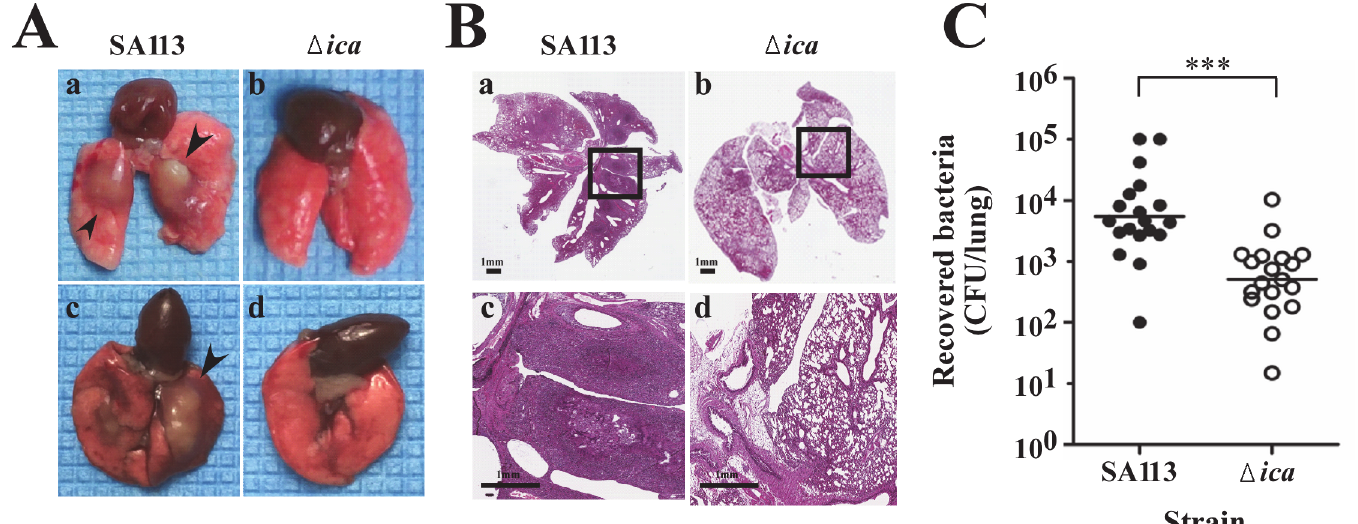
Fig 5. Effects of PIA/PNAG on lung infections in C57BL/6 mice. Mice were challenged with S . aureus SA113 or SA113 Δ ica by intratracheal injection and were sacrificed three days after. (A) Lungs were removed from infected mice and photographed. Arrowheads indicated abscesses formed on SA113-infected lungs (a, c). (B) Lung tissues were fixed, embedded in paraffin, thin-sectioned and stained with H&E. The boxed areas in panels a and b are magnified in panels c and d. The images shown are representative of each group (n = 5 per group). (C) The number of bacteria recovered from the lung tissues of the infected mice was determined (n = 19 per group). The median values are indicated with horizontal lines. Significant differences are denoted with *** p - value < 0.001.